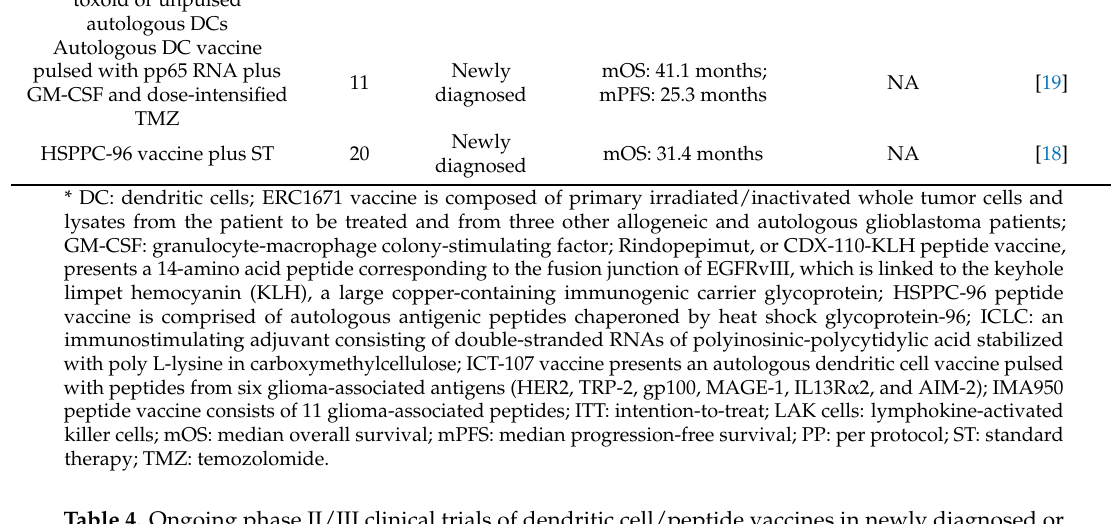
Table 4. Ongoing phase II/III clinical trials of dendritic cell/peptide vaccines in newly diagnosed or recurrent glioblastoma